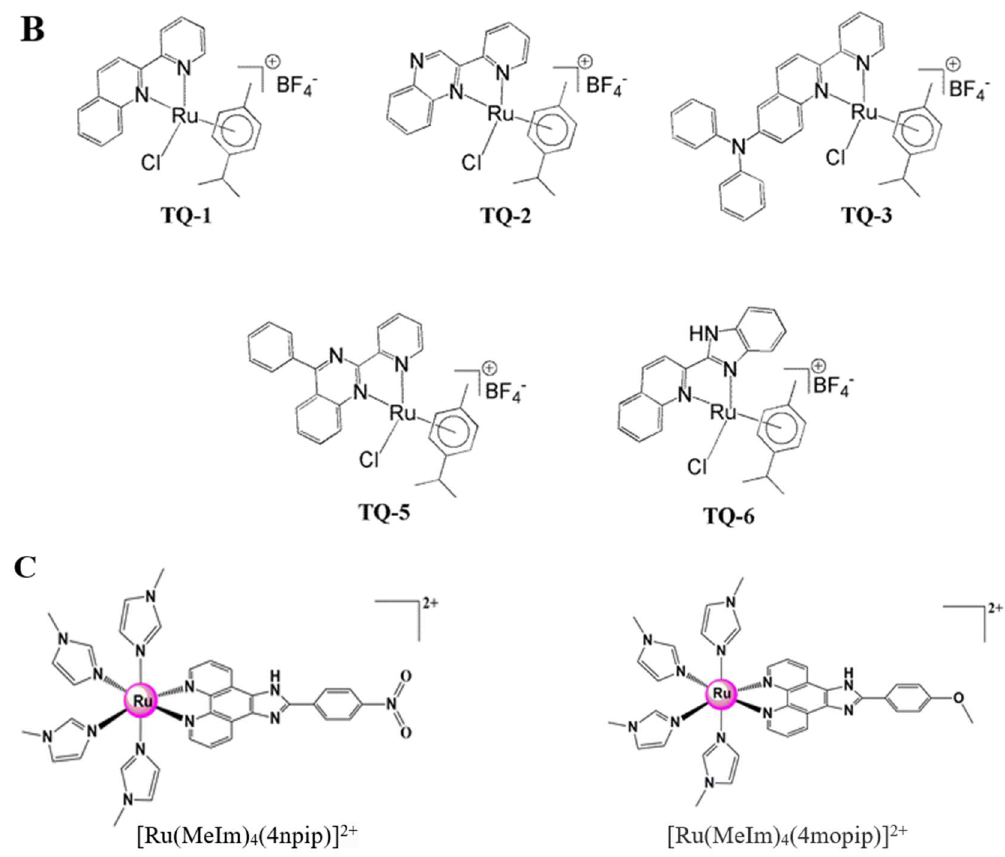
Figure 1. Synthetic procedure of the ligands ( A ) and its complexes ( B ) of TQ-1, TQ-2, TQ-3, TQ-5 and TQ-6; ( C ) Structures of ruthenium (II) methylimidazole complexes [Ru(MeIm) 4 (4npip)] 2+ and [Ru(MeIm) 4 (4mopip)] 2+ .